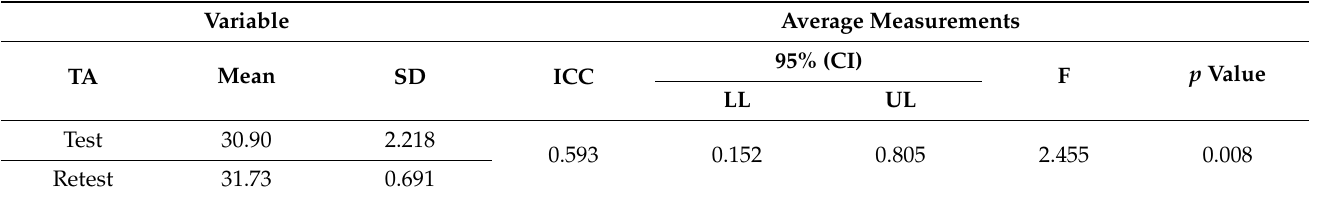
Table 2. Values in the ICC in the test–retest assessment of Type of Action (TA) and average measurement.